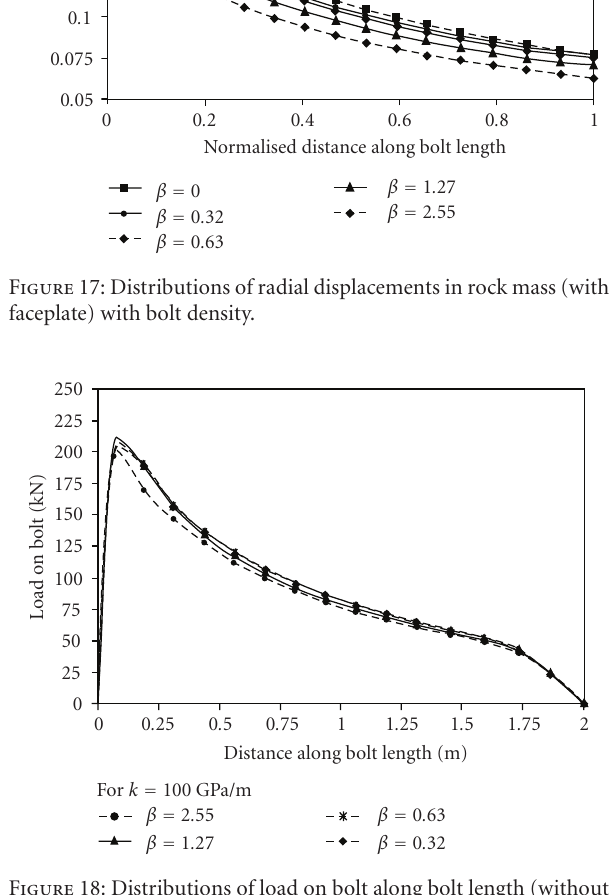
Figure 18: Distributions of load on bolt along bolt length (without